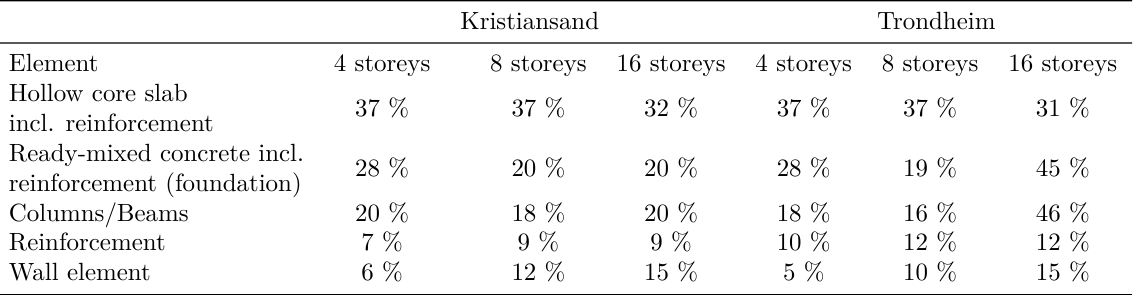
Table 4. Share of fossil GHG emissions in percentage from di ff erent construction materials in concrete load-bearing structures of 4-, 8- and 16-storey located in Kristiansand and